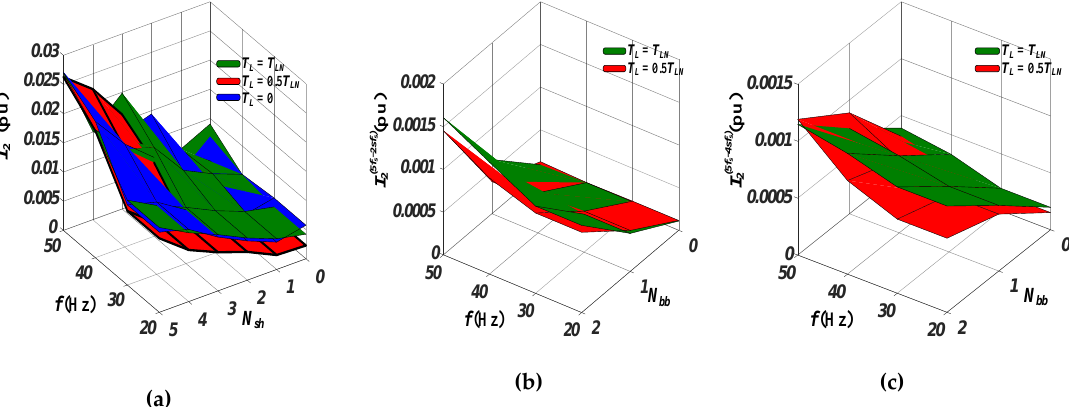
Figure 7. Changes of the amplitude value of negative-sequence instantaneous symmetrical component i 2 of the stator current with frequencies: f s ( a ), 5 f s − 2 sf s ( b ), and 5 f s − 4 sf s ( c ), for different number of shorted turns N sh ( a ), different number of broken bars N bb ( b , c ), and different load torque T L and supplied frequency f s .